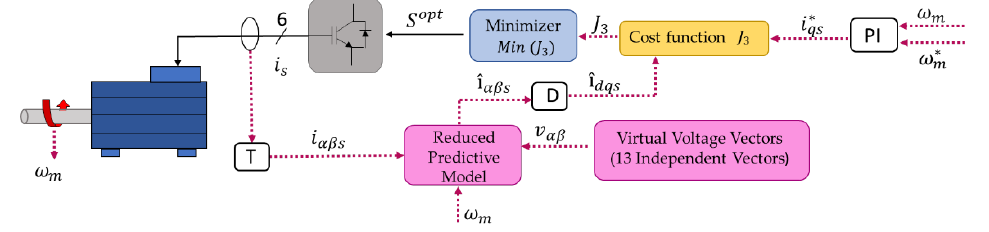
Figure 5. EVV-MPC scheme for six-phase induction motor drives.